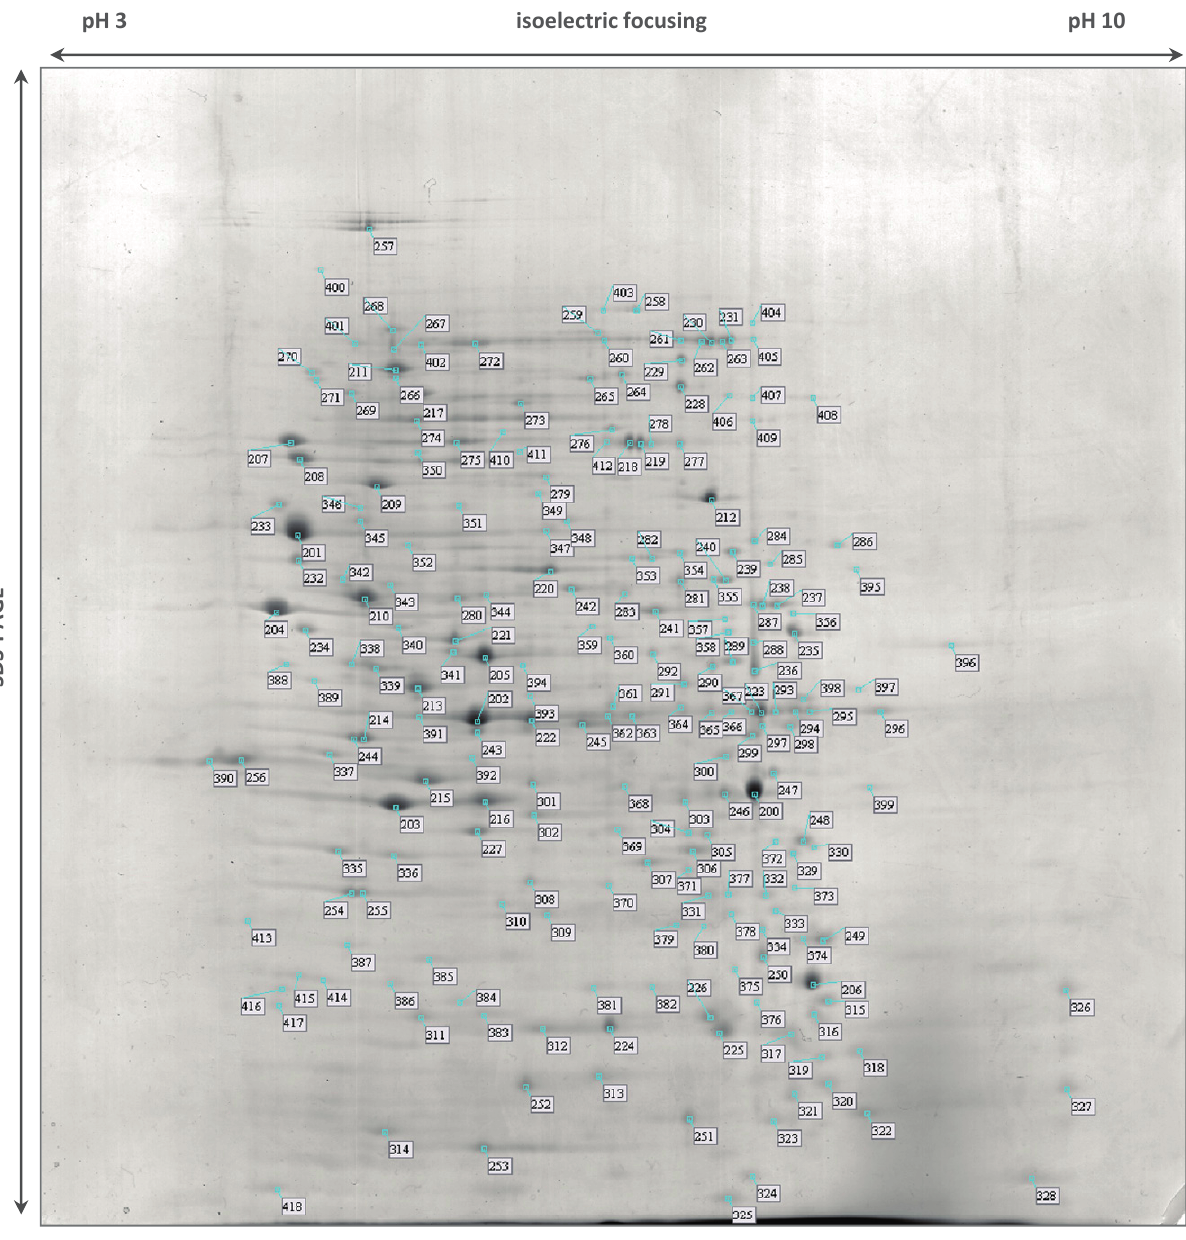
Figure 2. Stained 2-DE gel of total proteins of Salmonella Typhimurium SL1344 using IPG strips pH 3–10 NL for the first dimension. Numbered spots were excised for analysis by in-gel digestion and MALDI-TOF MS identification, described in Table